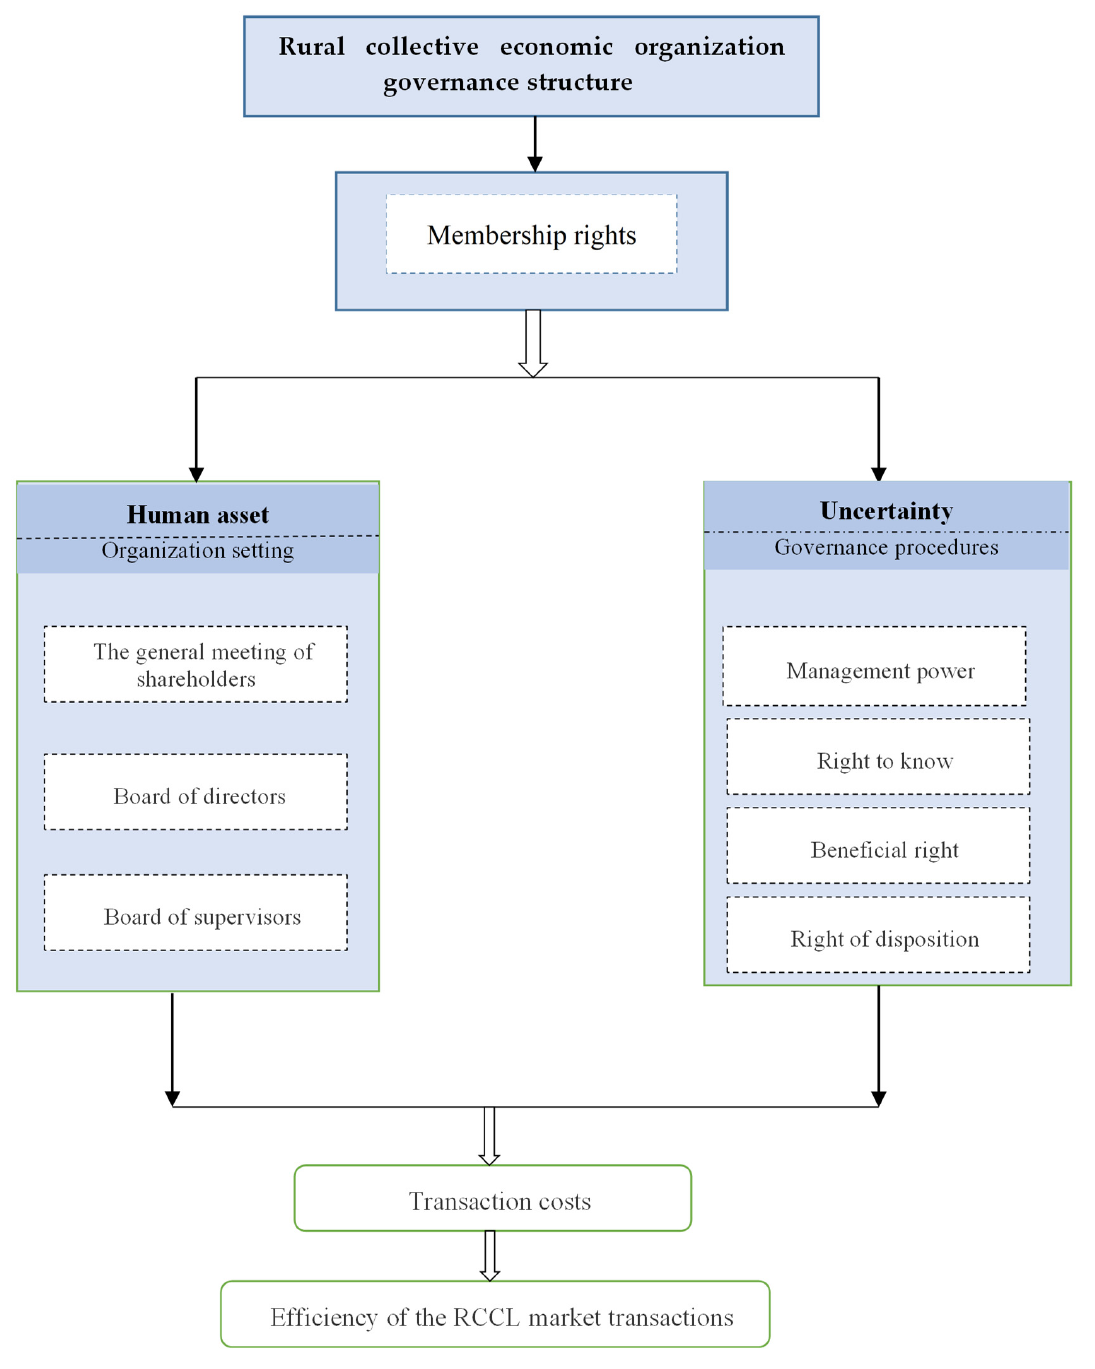
Figure 1. The theoretical framework.